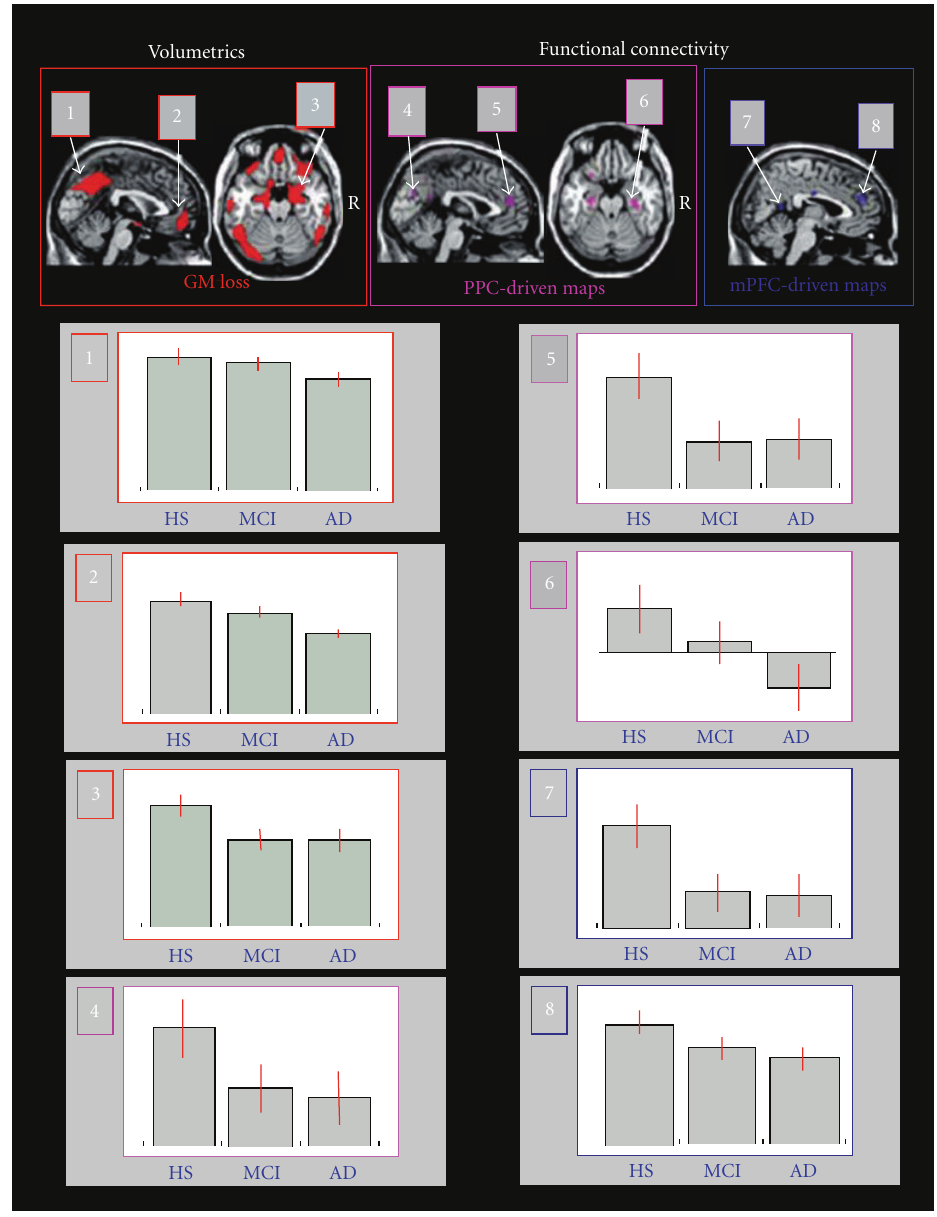
Figure 9: Distribution of reduced regional GMV (top panel on the left) and functional connectivity (top panel on the right) observed in patients with fully developed dementia (AD) compared with healthy subjects (HS). Changes of functional connectivity were assessed using both posterior cingulate (PCC) and medial prefrontal cortex (mPFC) driven connectivity maps (adapted with permission from